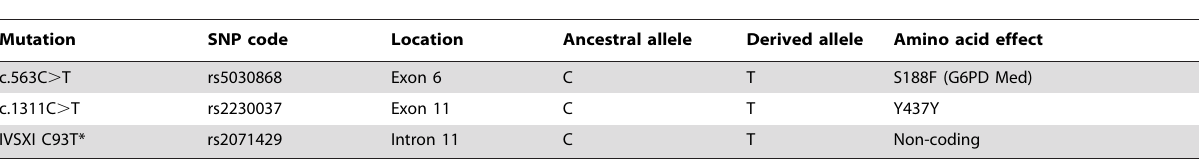
Table 1. G6PD molecular markers examined in the study.